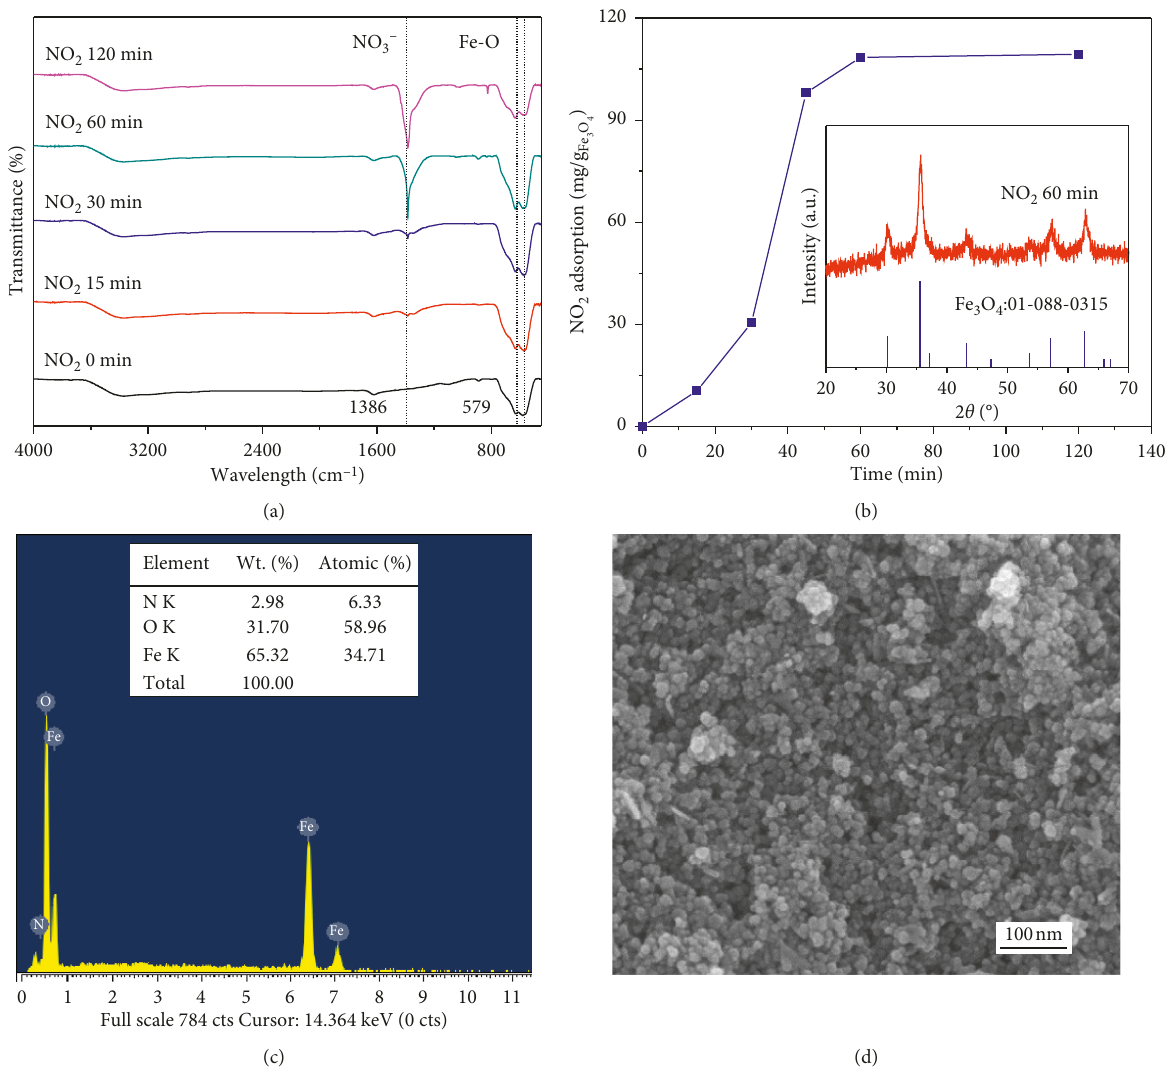
Figure 4: (a) FTIRof Fe 3 O 4 samplesafter exposingtoNO 2 gas attheparticular time;(b)NO 2 adsorption onFe 3 O 4 samples;(c) SEM-EDX spectra; (d) FE-SEM image of Fe